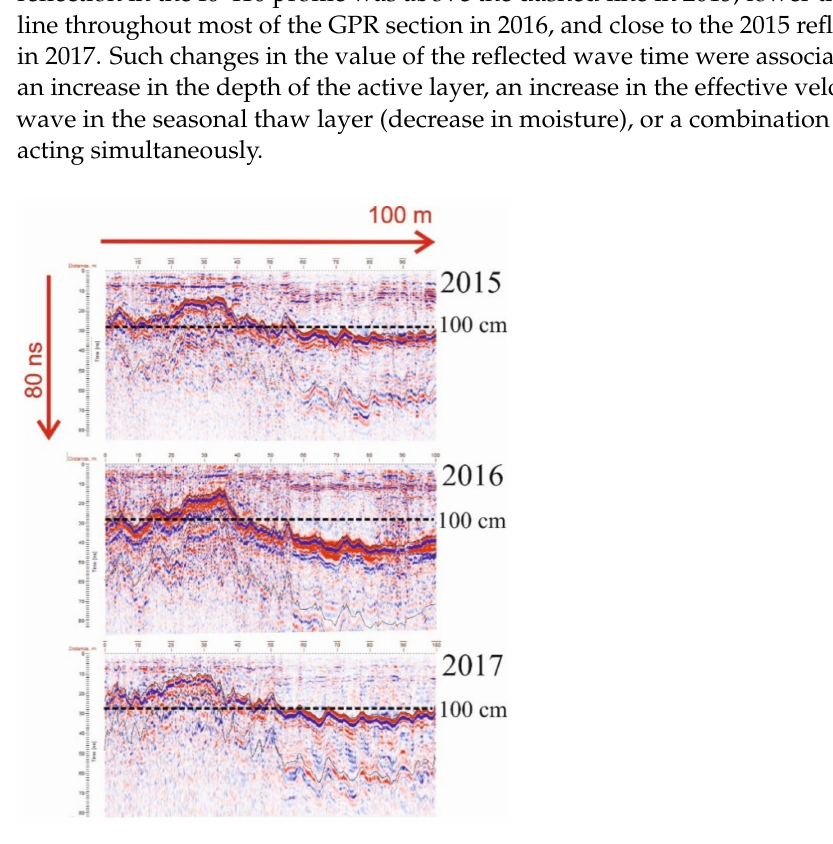
Figure 3. GPR data obtained in the Kashin area (CALM R24A-1) in 2015, 2016, and 2017 along the I0–I10 transect. The black line is the reflection event of the active layer bottom; the dotted black line is the multiple reflection events of the active layer bottom. The dashed line corresponds to a depth of 100 cm and a constant speed of 7